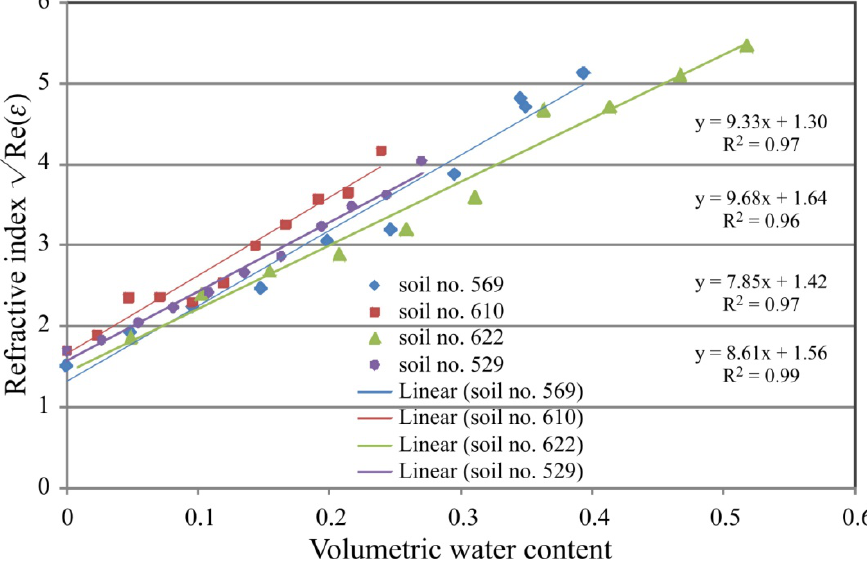
Table 3 . Comparison of FDR calibrations of the analysed sensors with Malicki TDR calibrations [23]. (Figure 13 )